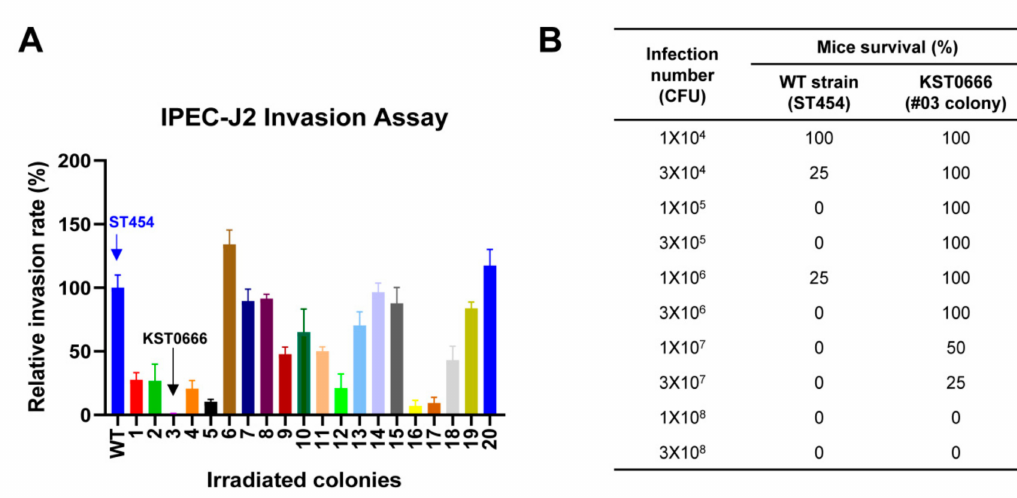
Figure 1. Selection of live attenuated Salmonella strain by radiation mutation technology (RMT). ( A ) The cell invasion ability of Salmonella Typhimurium ST454 WT and its irradiated mutants were tested in the porcine intestinal epithelial cell line IPEC-J2. IPEC-J2 cells were infected with ST454 WT or its irradiated mutants ( n = 20) at a multiplicity of infection (MOI) of 10, bacterial viability in cell lysates that were serially diluted was counted at 30 min post-infection, and invasion rates were calculated as (recovered CFU/original CFU) × 100%. ( B ) The comparison of LD50 values measured in BALB/c mice ( n = 4 per group) injected with either ST454 or KST0666 strain. The survival of infected mice was monitored for 14 days.